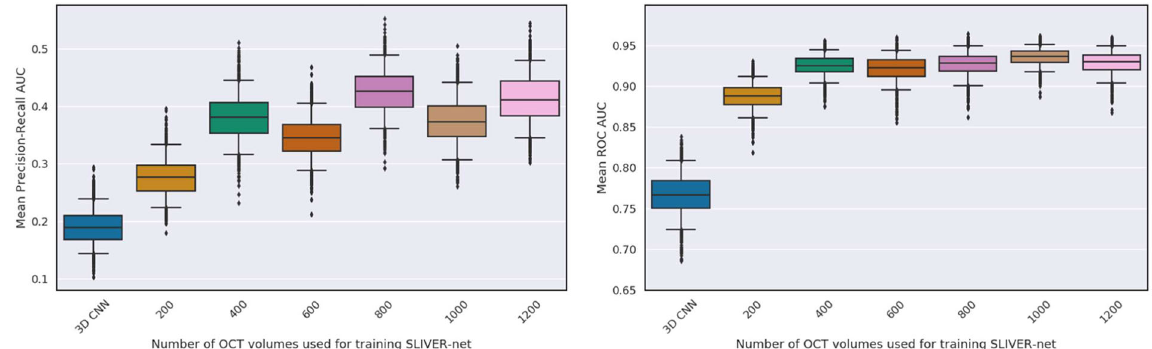
Fig. 6 The effect of sample size on SLIVER-net ’ s performance. 3D CNN was trained on full data. Top: Mean precision-recall AUC across all biomarkers. Bottom: Mean ROC AUC across all biomarkers. Error bars represent 95% con fi dence interval (CI) calculated using a bootstrapping procedure.